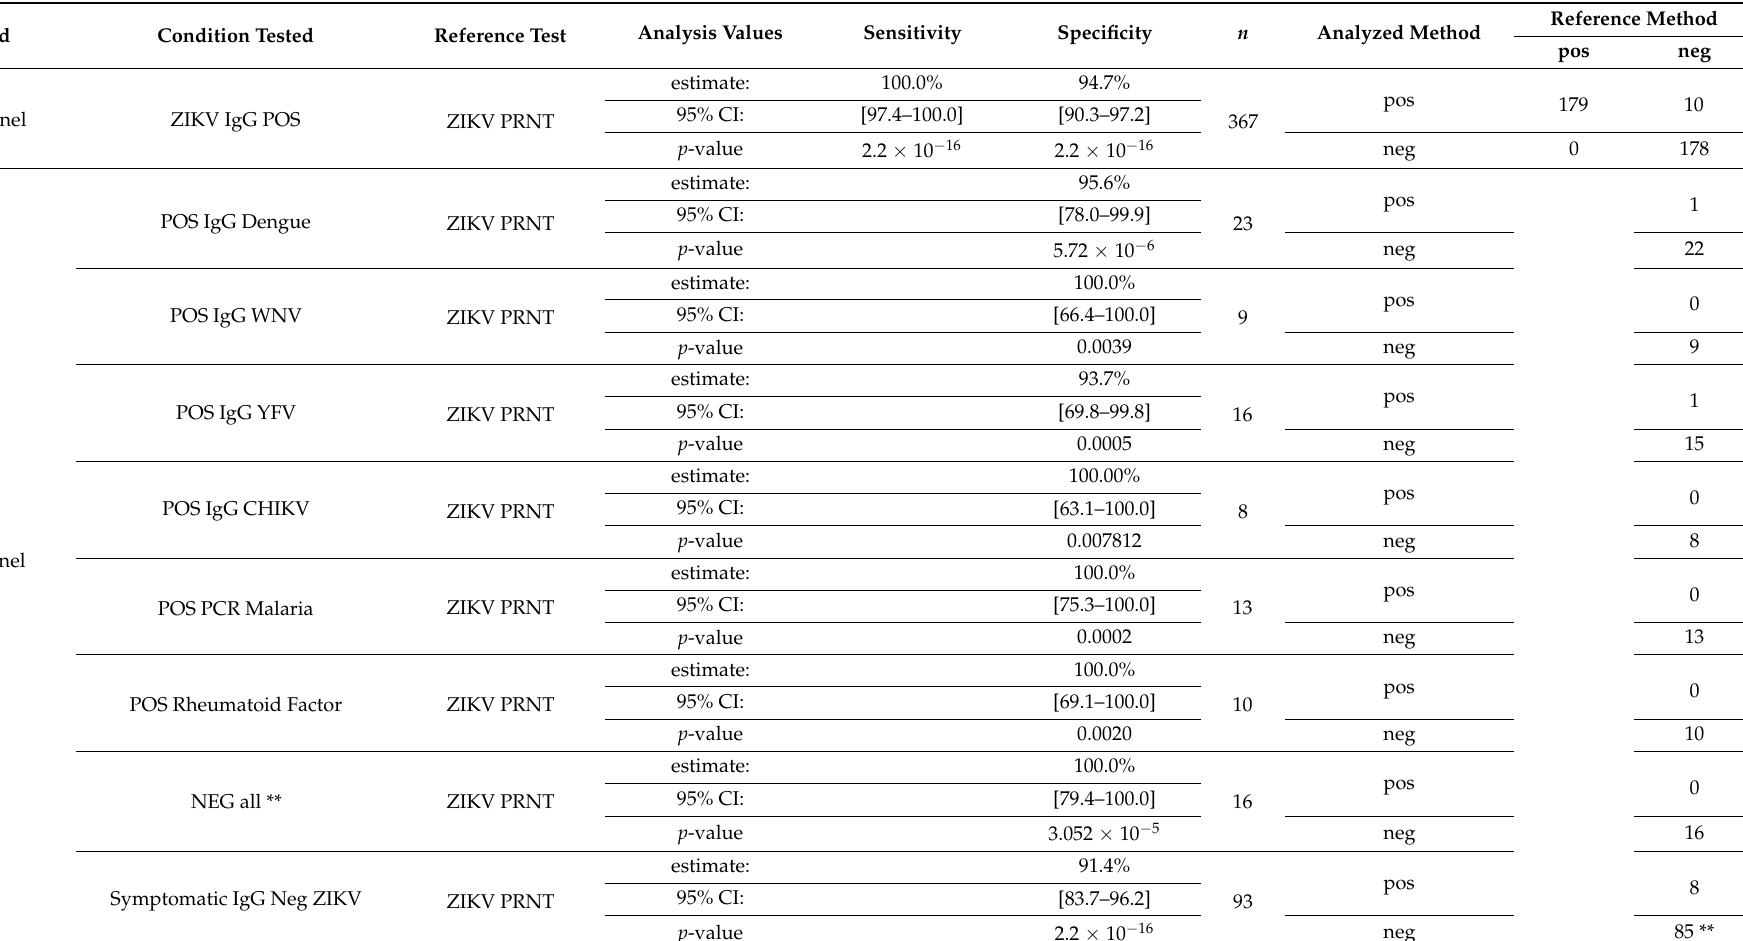
Table 5. Performance per sample